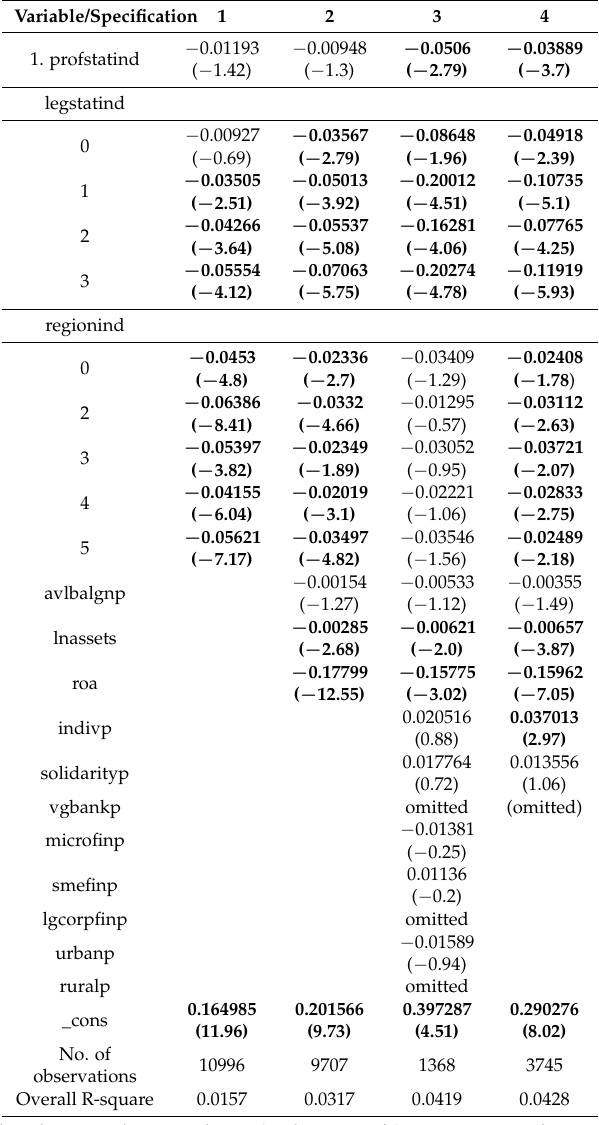
Table A1. PAR30 panel